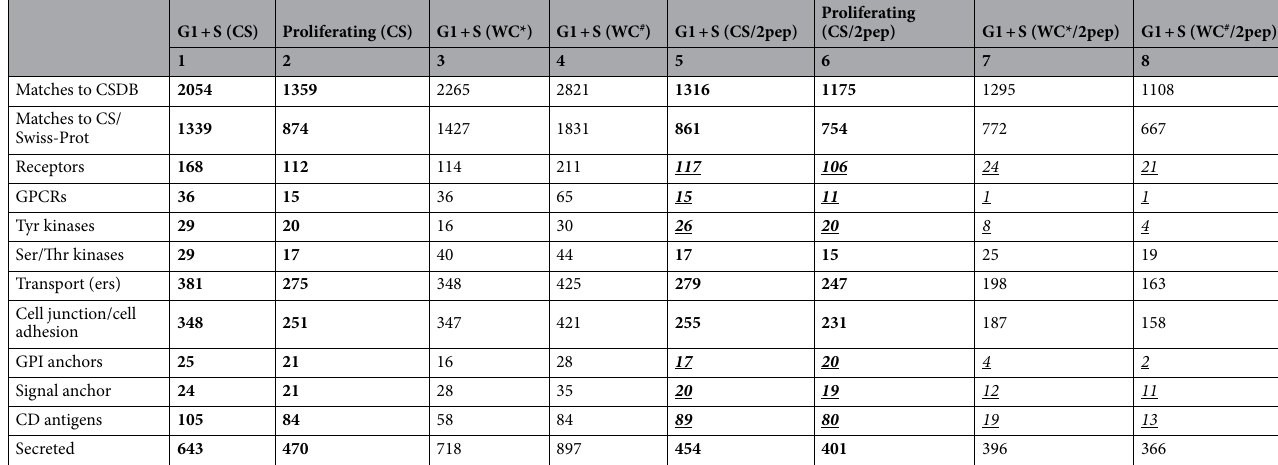
Table 1. Cell-surface protein identification effectiveness with and without enrichment in cell-surface proteins, by considering the whole protein set or only proteins matched by two unique peptides. CS cell surface, WC whole cell, 2pep-2 unique peptides. *Data acquired with a QExactive Plus Orbitrap mass spectrometer. # The analysis included many replicates; as a result, a larger number of proteins were identified. Bold values represents protein count data from SKBR3 cells subjected to enrichment in cell-surface proteins. Underlined/ italic values indicate conditions for which a substantial improvement in cell-surface protein enrichment was observed (vs. whole cell, non-enriched